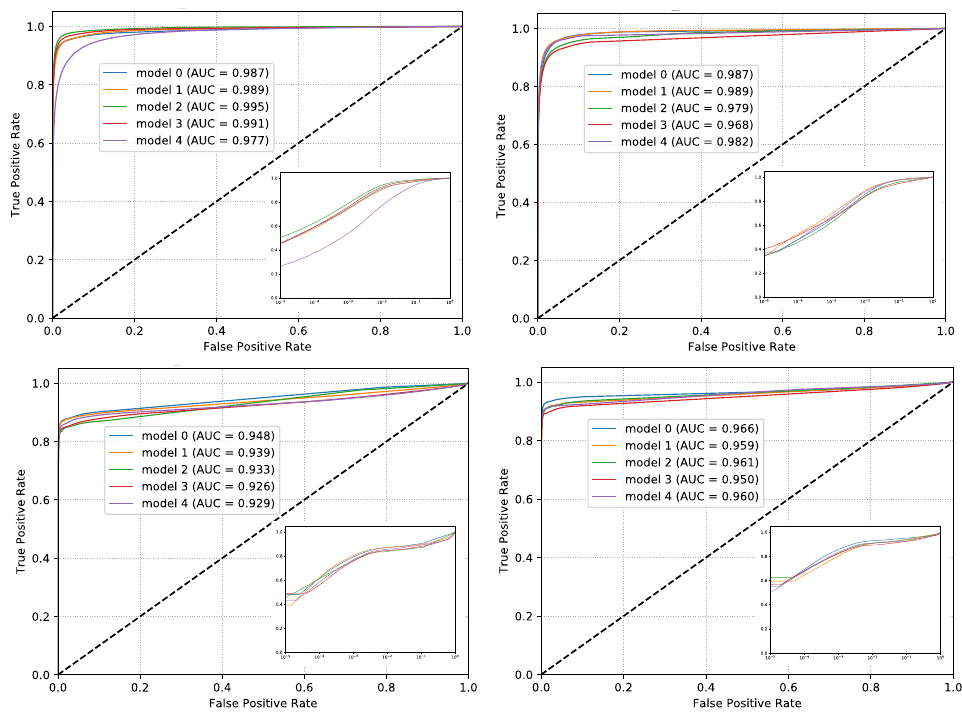
Figure 4. ROC curves of the five models trained with the cross validation technique for the segmen- tation task. Top are EF-bce ( left ) and Siam-bce ( right ) models, while bottom are EF-wbced ( left ) and Siam-wbced ( right ) models. The inset plots show the ROC curves with logarithmic scale for the x